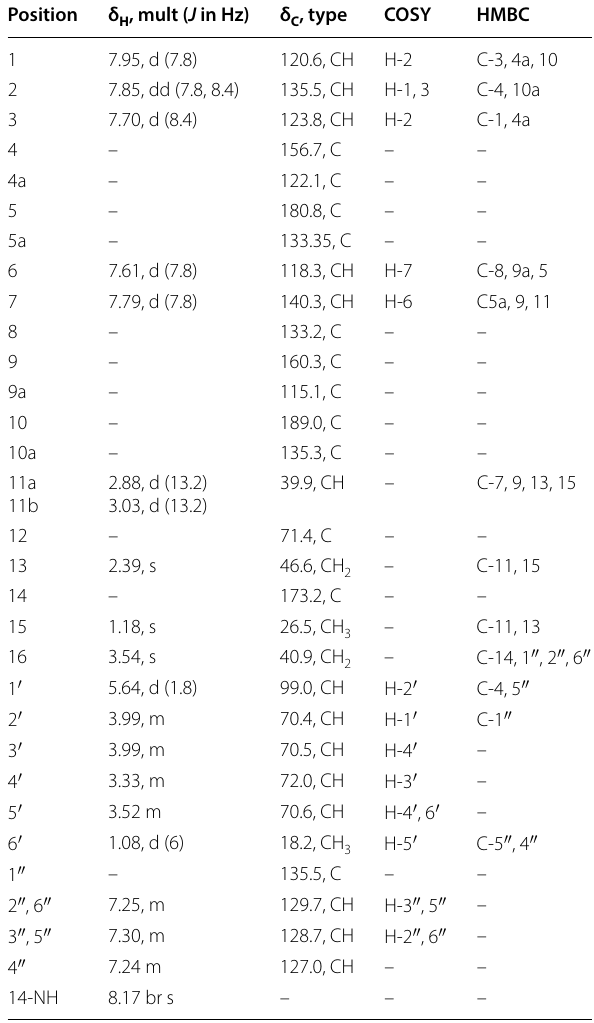
Table 3 1 H and 13 C NMR data (DMSO-d of